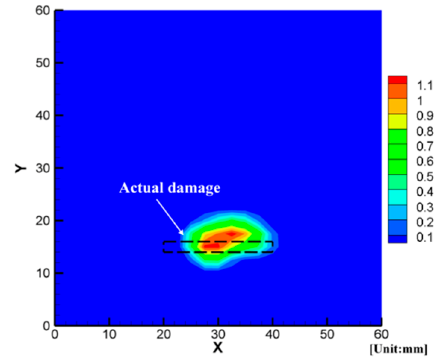
Figure 10. Image of an aluminum plate with a non-penetrating slit.